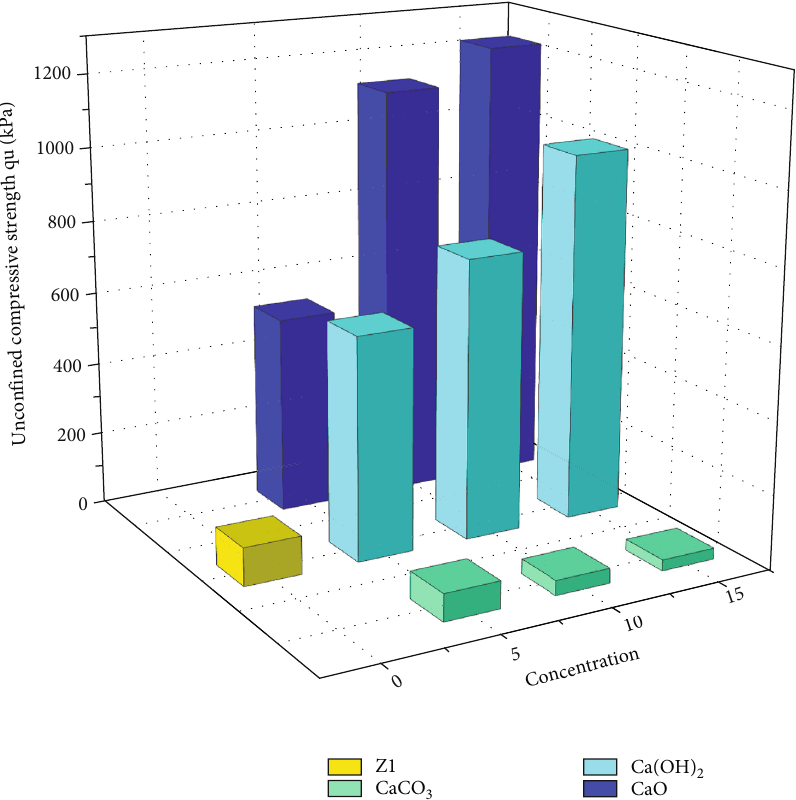
Figure 3: The uncon fi ned compressive strength of each sample at 0.5% Zn 2+